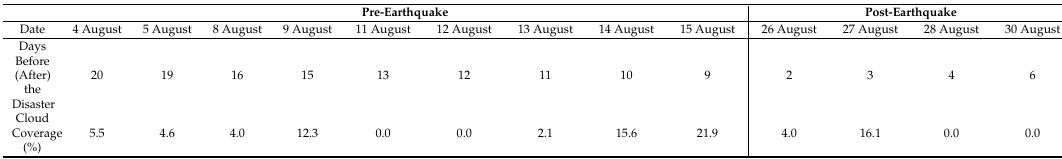
Table 4. The dates and cloud coverages of pre- and post-earthquake DNB images of the Central Italy